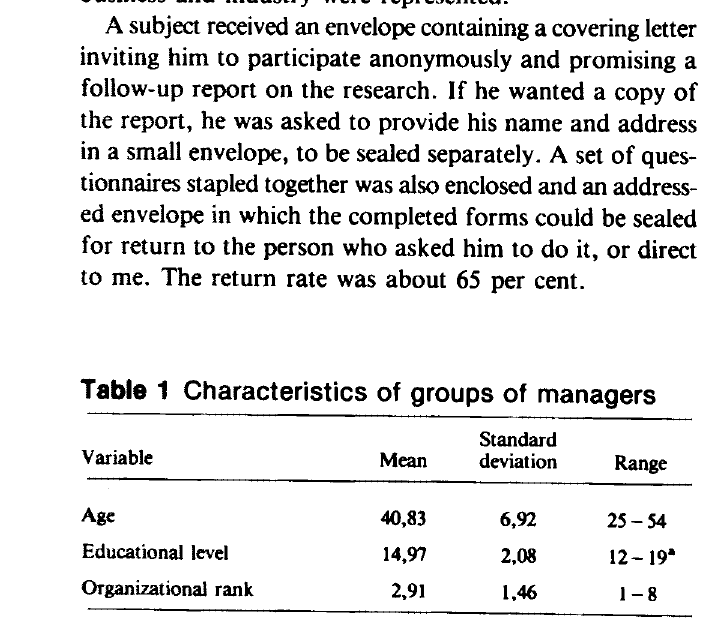
Table 1 Characteristics of groups of